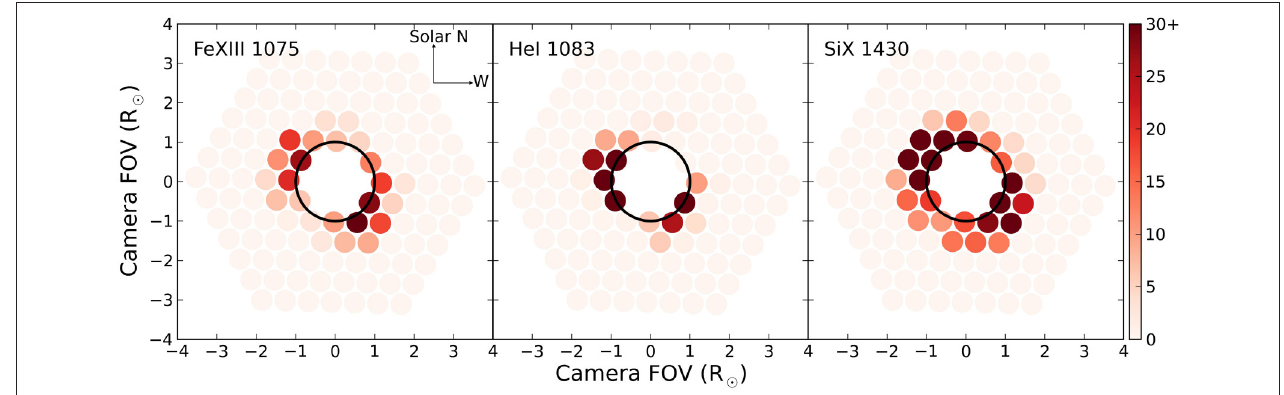
FIGURE 2 | Spatial sampling of the corona during the March 29, 2006 total eclipse. A hexagonal array of 127 fibers sparsely sampled the coronal image plane. Each plot shows the signal/noise measured in each fiber for the lines indicated. One key result from these measurements is the large spatial extent of bright SiX1430 emission compared to FeXIII1075